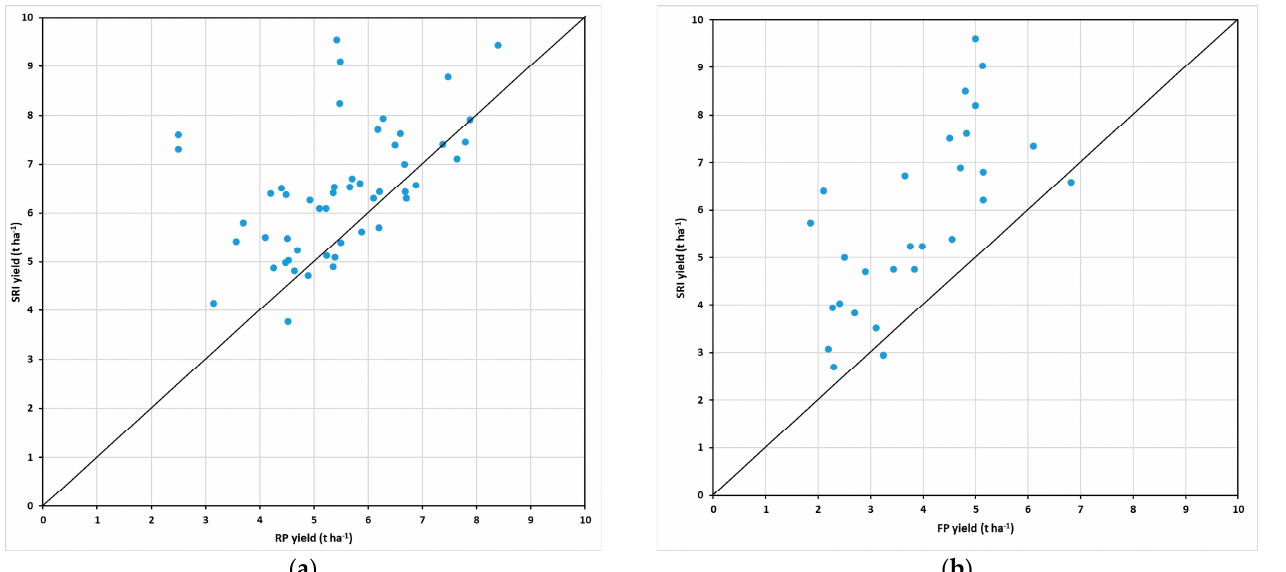
Figure 2. SRI grain yields (t ha − 1 ) vs. comparison yields achieved using ( a ) recommended practices (RPs) and ( b ) farmer practices (FPs) from 27 countries. Each data point represents one experimental record. Points above the 1:1 line represent favorable productivity responses to SRI.